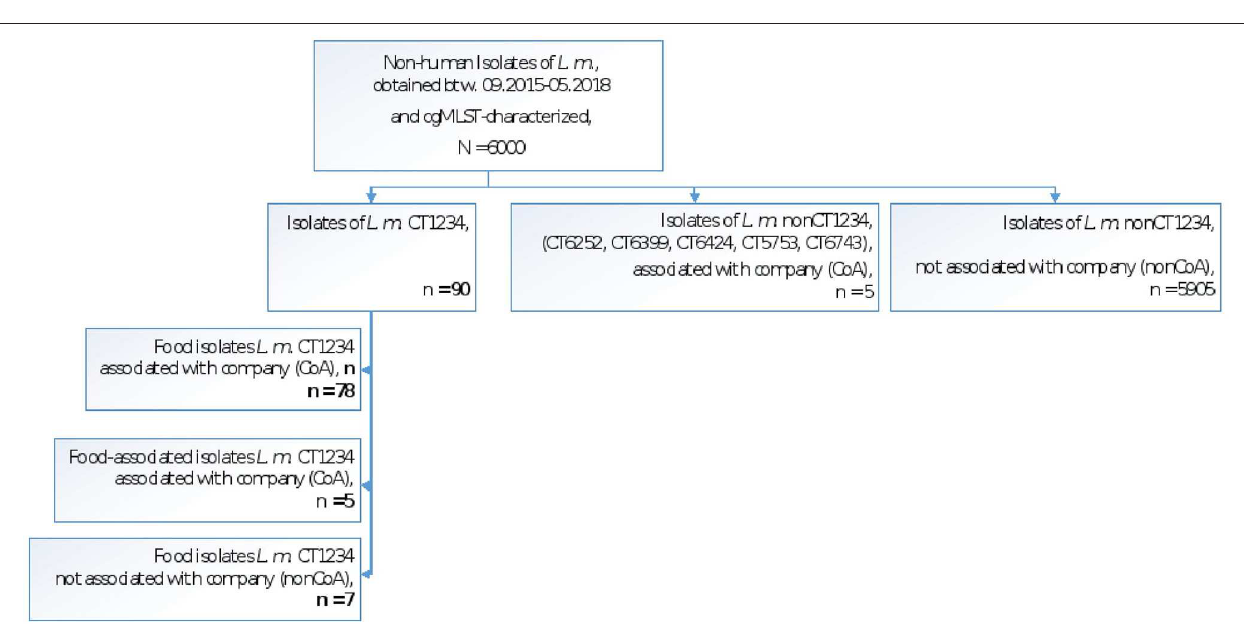
FIGURE 2 | Non-human L. monocytogenes isolates of the AGES strain collection ( L.m. CT1234, L.m. nonCT1234) with and without company A linkage (CoA,